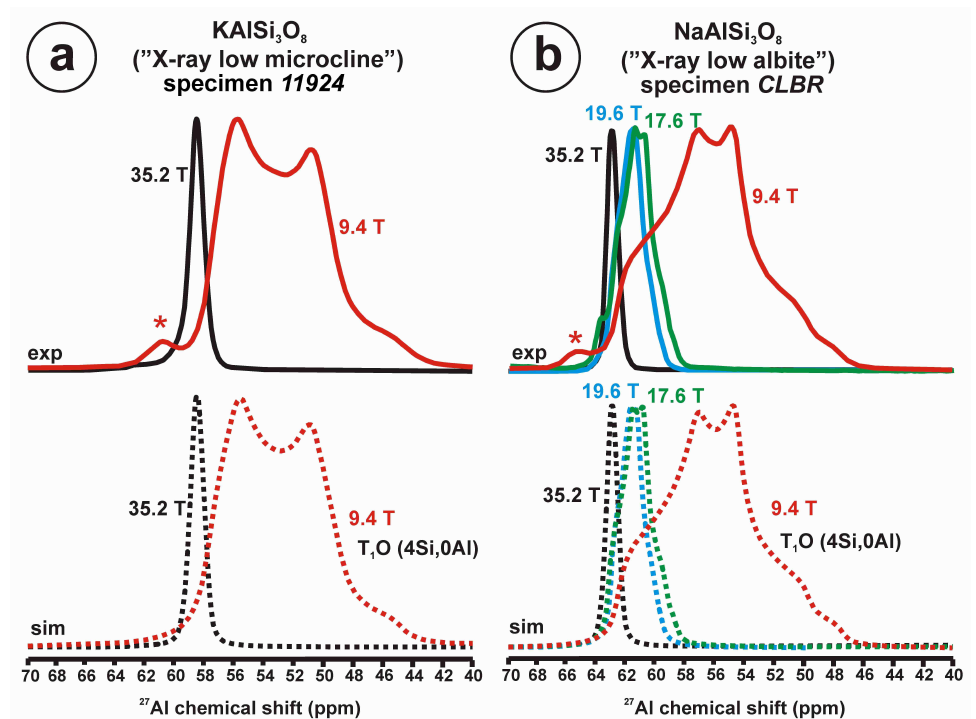
Figure 25. ( a ) The 27 Al MAS spectra (exp) of specimen 11924 of “X-ray low microcline” at 9.4 T (red) and at 35.2 T (black), with simulations (sim) as dotted curves below. ( b ) The 27 Al MAS spectra (exp) of specimen CLBR of “X-ray low albite” at 9.4 T and υ r = 12.8 kHz (red), at 17.6 T and υ r = 30 kHz (green), at 19.6 T and υ r = 10 kHz (blue) and at 35.2 T, υ r = 12.5 kHz (black curve); * for the transition 3/2 recorded at 9.4 T in the two specimens; Al atoms in T 1 O site are recorded. See Figure 1 for the experimental conditions of the 27 Al spectra at 35.2 T; ref. [4] for the spectra at 9.4 T; 4 mm rotor, pulses of 0.5 µ s, ν r = 10 kHz and a recycle delay of 2 s for the spectrum at 19.6 T; 4 mm rotor, pulses of 8 µ s, ν r = 30 kHz and a recycle delay of 30 s for the spectrum at 17.6 T.